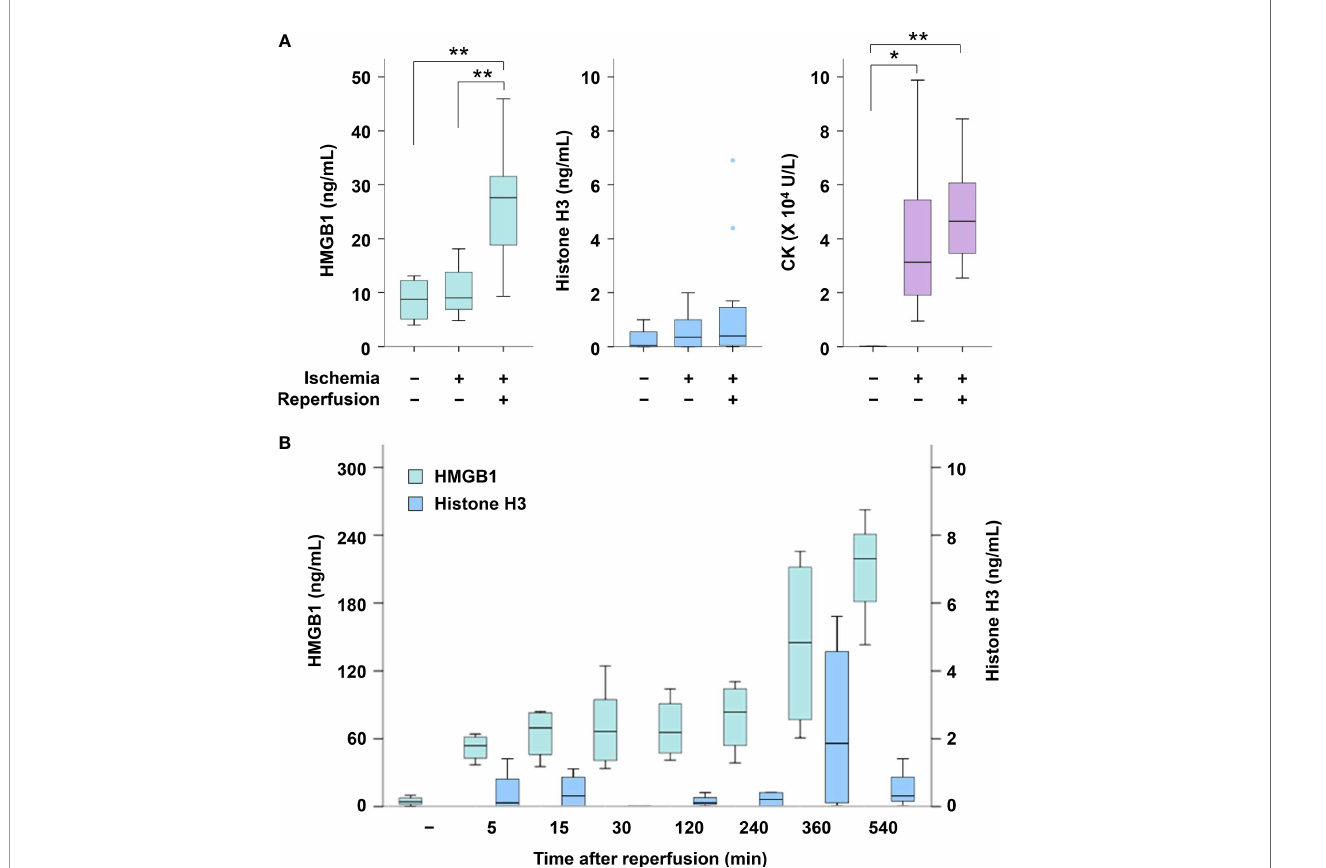
FIGURE 2 | Serum levels of HMGB1, histone H3 and CK in mice with or without I/R. (A) Serum levels of HMGB1, histone H3 and CK were measured in normal mice ( n = 4), mice with 12 h of ischemia ( n = 8), and mice with 12 h of ischemia followed by 30 min of reperfusion ( n = 15). * P < 0.05, ** P < 0.01. (B) Serum levels of HMGB1 and histone H3 were measured at 5 min ( n = 4), 15 min ( n = 4), 30 min ( n = 6), 120 min ( n = 4), 240 min ( n = 4), 360 min ( n = 4) and 540 min ( n = 3) after I/ R. Representative data of two independent experiments are